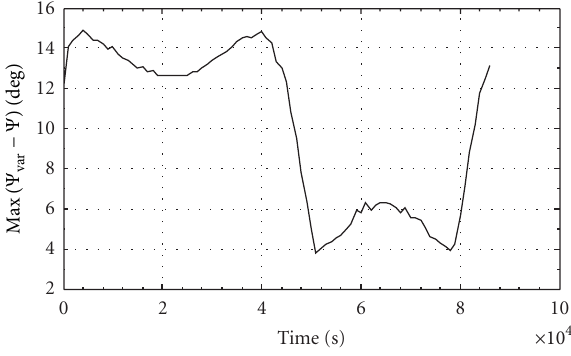
− Ψ) in an orbital period of GEOSAR. Figure 8: Max (Ψ var